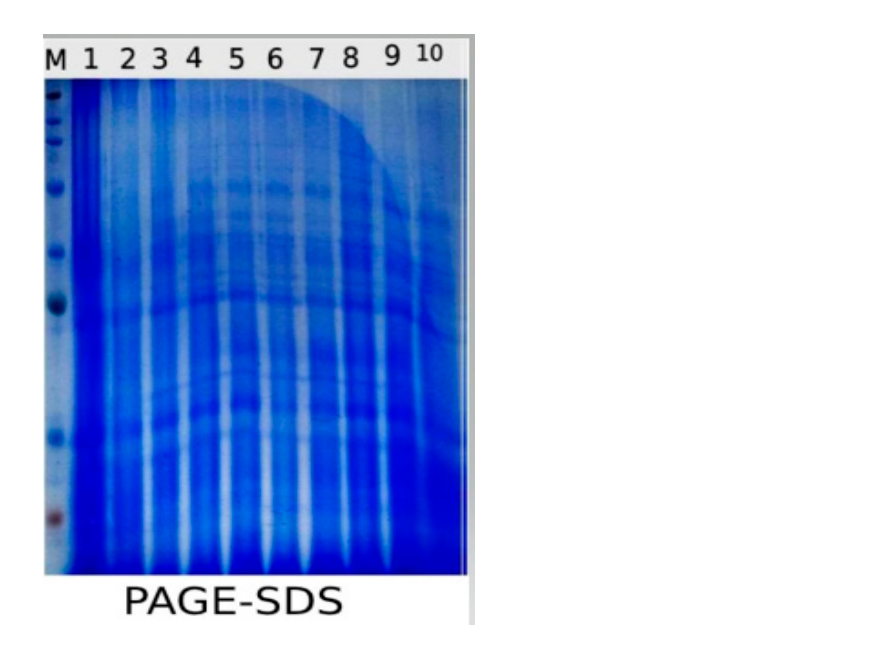
Figure 10. Effect of salinity (S) and foliar application of chitosan dissolved in different organic acids (Ch ACE, Ch ASC, Ch CIT and Ch MAL) and their interactions on Protein electrophoretic banding patterns of tomato leaves. L1 = Control, L2 = Ch ACE, L3 = Ch ASC, L4 = Ch CIT, L5 = Ch MAL, L6 = S, L7 = S + Ch ACE, L8 = S + Ch ASC, L9 = S + Ch CIT and L10 = S + Ch MAL. Table 6. Protein electrophoretic banding patterns of salinity (S) and foliar application of chitosan dissolved in different organic acids (Ch ACE, Ch ASC, Ch CIT and Ch MAL) and their interactions of tomato plants. L1 = Control, L2 = Ch ACE, L3 = Ch ASC, L4 = Ch CIT, L5 = Ch MAL, L6 = S, L7 = S + Ch ACE, L8 = S + Ch ASC, L9 = S + Ch CIT and L10 = S + Ch MAL.